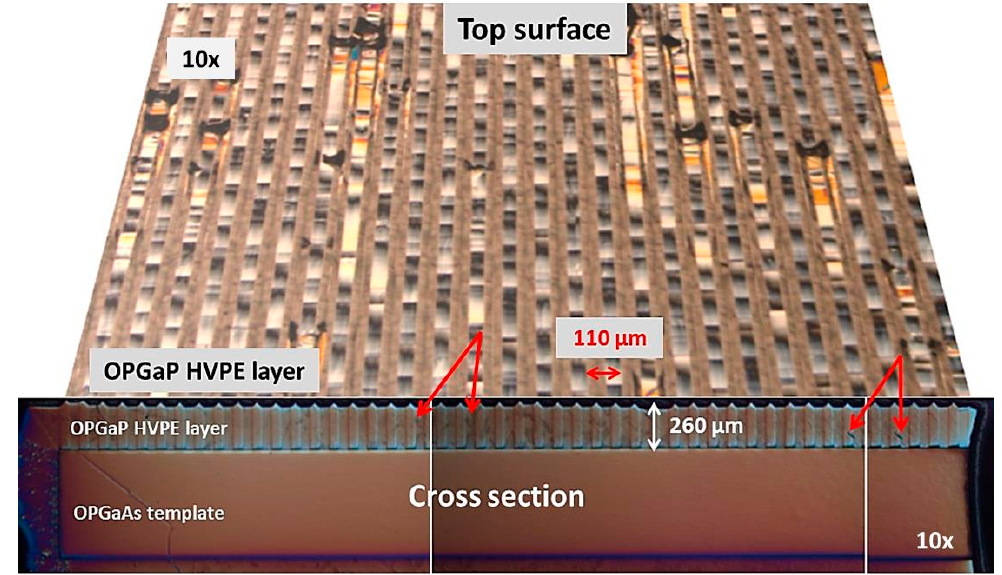
Figure 29. A 3D-reconstruction of heteroepitaxy of OPGaP on OPGaAs templates based on microscopic images that represent the top surface and the cross section—3 images in a row where the red arrows show where they must be stitched [59]. (Reproduced from [59] with the permission of OSA).